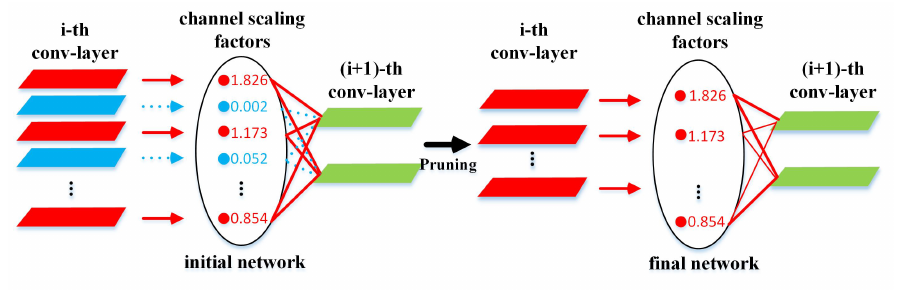
Figure 2. Channel-level